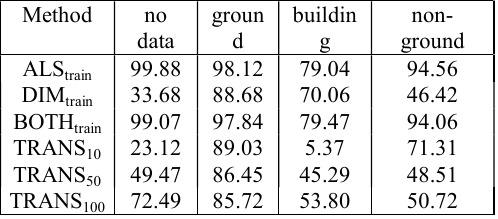
Table 1. F1-Score for ALS test [%]